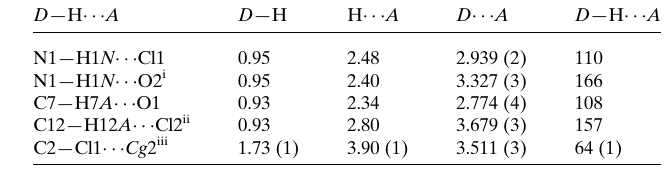
Table 1 Hydrogen-bond geometry (A˚ , (cid:2) ). Cg 2 is the centroid of the C8–C13 ring.